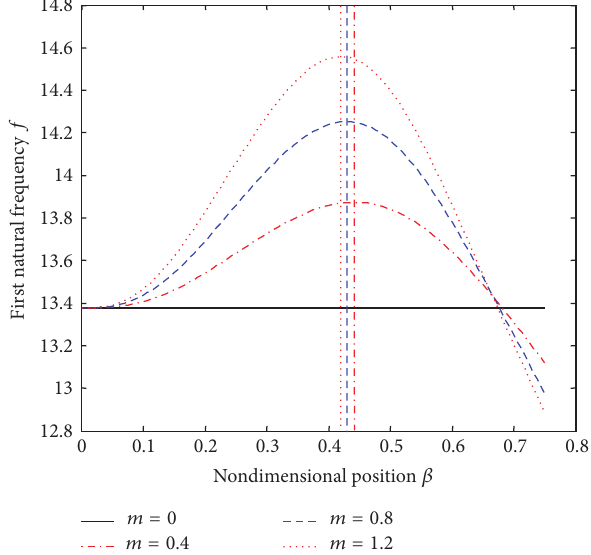
Figure 3: Effect of the concentrated mass location on the first natural